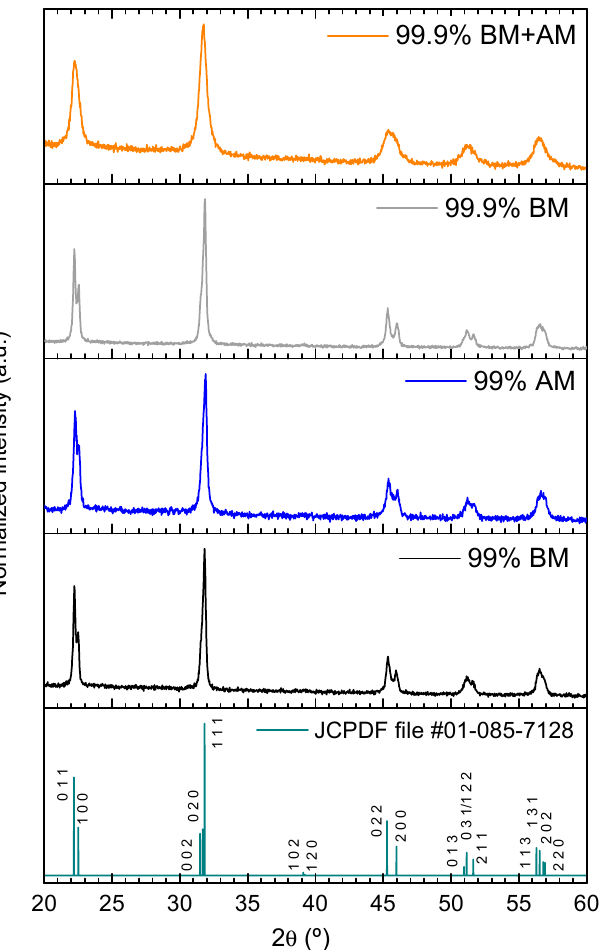
Figure 2. X-ray diffraction (XRD) patterns of produced KNN powders. JCPDF file #01-085-7128 of orthorhombic K 0.5 Na 0.5 NbO 3 is included for comparison, and no secondary phases are identifiable.